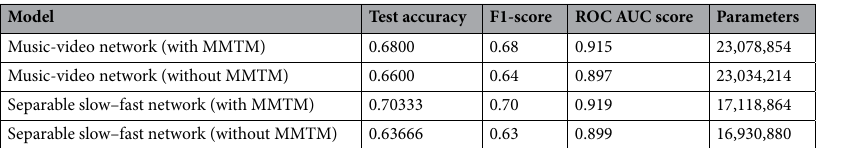
Table 1. Effect of the MMTM block using music video test samples (training from the scratch).